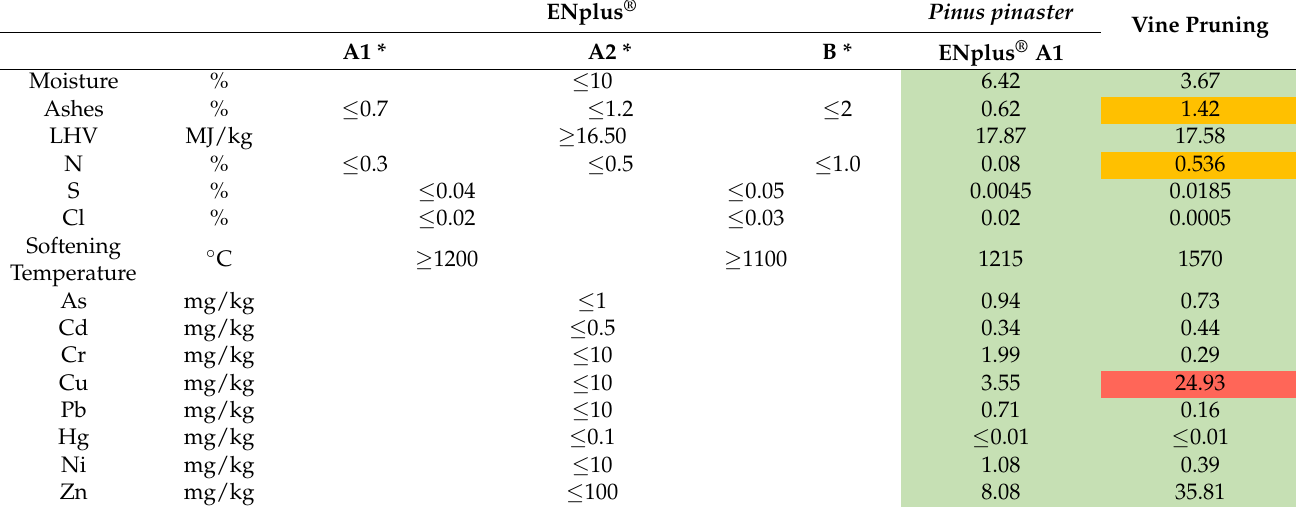
Table 13. Parameters defined by the ENplus ® standard and the results obtained for Pinus pinaster wood pellets and the biomass of vine